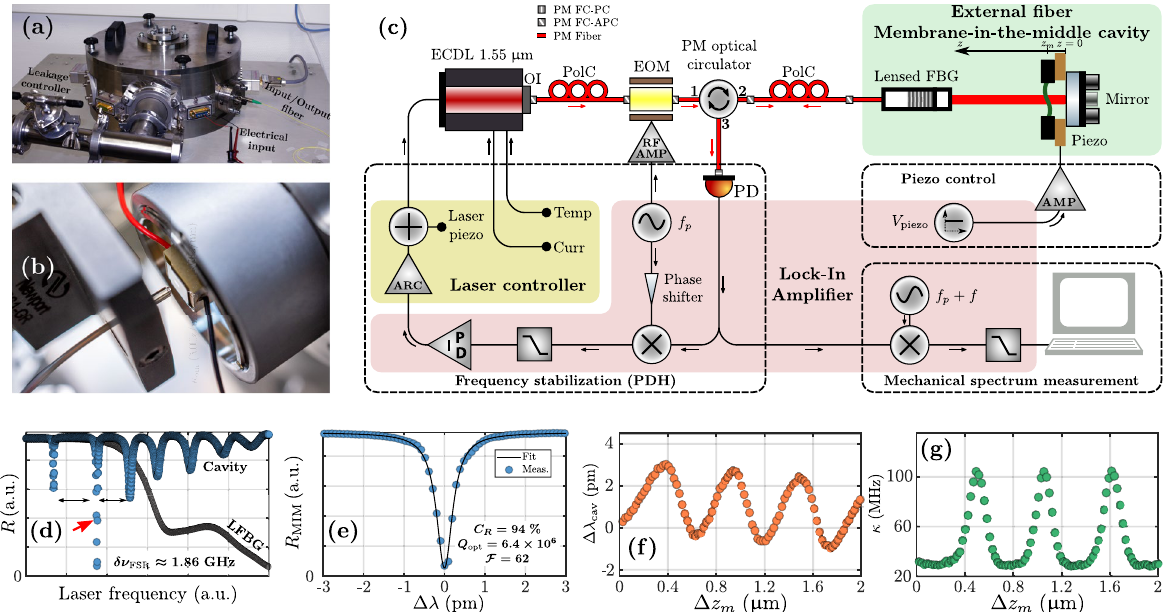
Figure 1. The lensed FBG-based optomechanical MIM cavity. ( a ) Picture of the vacuum chamber. ( b ) Picture of the cavity itself with the silicon nitride membrane passively aligned with the dielectric mirror using a piezo- electric element as a spacer in between. ( c ) Schematic of the experimental setup used for the thermomechanical characterization with a PDH frequency stabilization scheme. ARC: Analog Remote Control, AMP: Amplifier, ECDL: External-Cavity Diode Laser, EOM: electro-optic modulator, FBG: Fiber Bragg Grating, FC-PC/ FC-APC: Fiber Coupled connectors with Physical Contact/Angled Physical Contact, OI: Optical Isolator, PD: PhotoDetector, PID: Proportionnal-Integral-Derivative, PolC: Polarization Controller, PM: Polarization Maintaining. ( d ) Typical optical spectra in reflection of the cavity and comparison with the optical response of the lensed FBG (LFBG) alone. The corresponding free spectral range �ν FSR is indicated with double arrows. ( e ) Resonance peak of highest contrast [indicated by the red arrow in ( d )] fitted by a Lorentzian shape function (simplified Airy function, suitable because of the high optical quality factor) to extract to the contrast C R , the quality factor Q opt and the optical finesse F . ( f ), ( g ) Measured resonance wavelength shift (cid:31) (cid:31) cav (orange) and decay rate κ (green) as a function of the membrane relative position along the cavity axis. The initial position 0 ) is the situation without any voltage applied on the piezo-electric material (minimum position ( (cid:31) z m = 3.25 mm z 1 L m / 2 where L m is the membrane = + in the linear part, and δ f PI is the correction bandwidth. Before any stabilization, the ideal modulation parameters are found. The evolution of the error signal slope as a function of the modulation depth β and frequency f p is 1.08 ). Secondly, f p analyzed. Firstly, there is an optimal depth for which the error sensitivity is maximized ( β ≈ is chosen in the high frequency regime i.e. above the cavity bandwidth κ 28 . Typical parameters for the previously 75MHz . This preliminary analysis allows the system to be placed 42.1 MHz and f p presented cavity are κ = ≈ in an ideal situation to improve its sensitivity to frequency fluctuations induced on the optical resonance. The W / Hz error sensitivity s err (measured output power variation per resonance frequency shift) is given by: